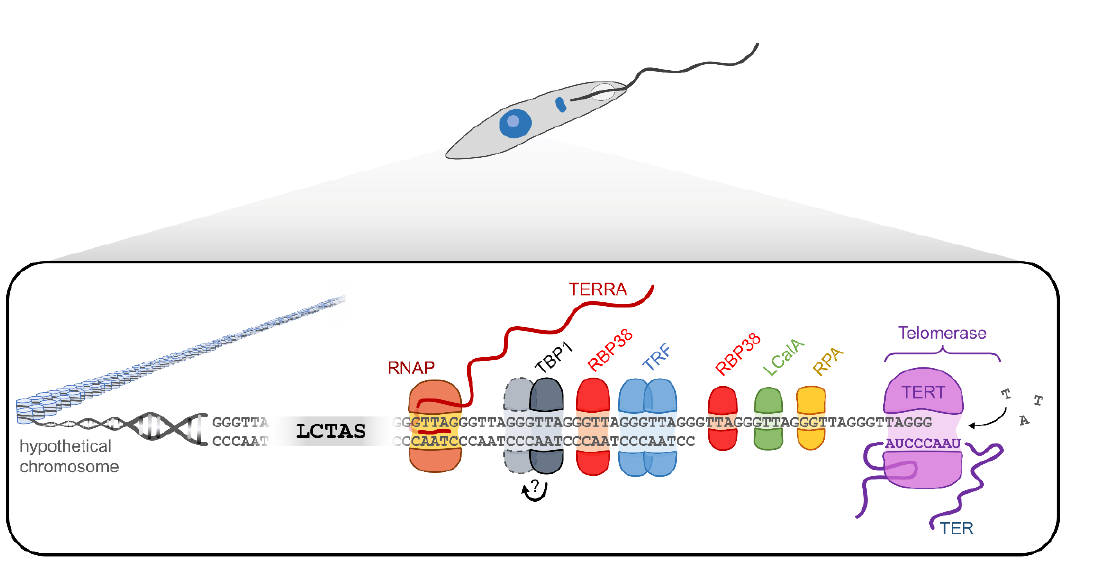
Figure 3. Leishmania spp. telomeres are formed by subtelomeric regions (LCTAS); a double-stranded region; a single-stranded protrusion (3 ′ -G overhang); and associated proteins, such as TBP-1, TRF, Rbp38, RPA-1, and LCalA. Of note, it is not clear if TBP1 binds DNA as a monomer or dimer. The telomeres are elongated by telomerase, a ribonucleoprotein composed minimally by TERT and TER. From the C-rich strand of the telomeric region, ncRNAs called TERRAs are transcribed and appear to be involved in telomere length regulation. Adapted from da Silva et al., 2012 [66].